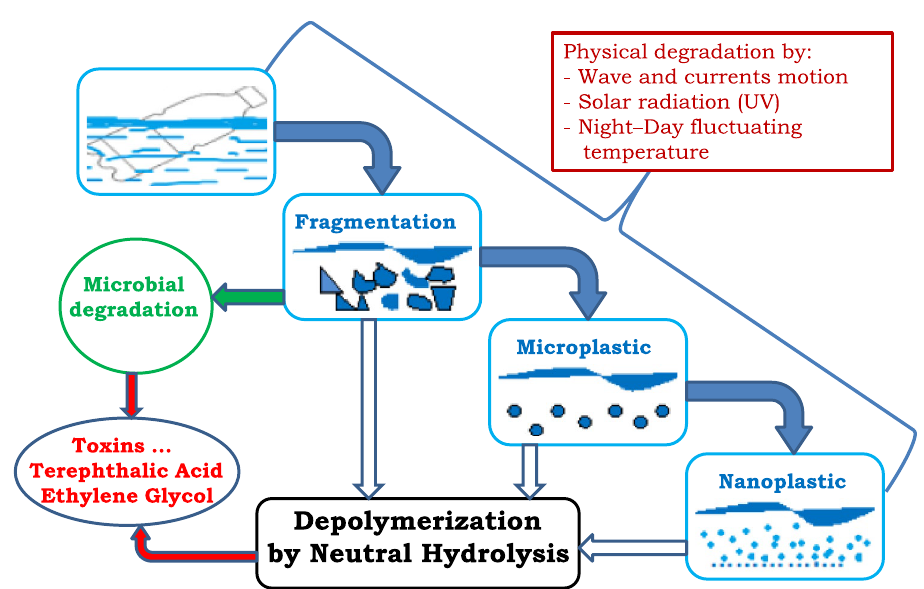
Figure 2. Factors involved in PET waste depolymerization in marine